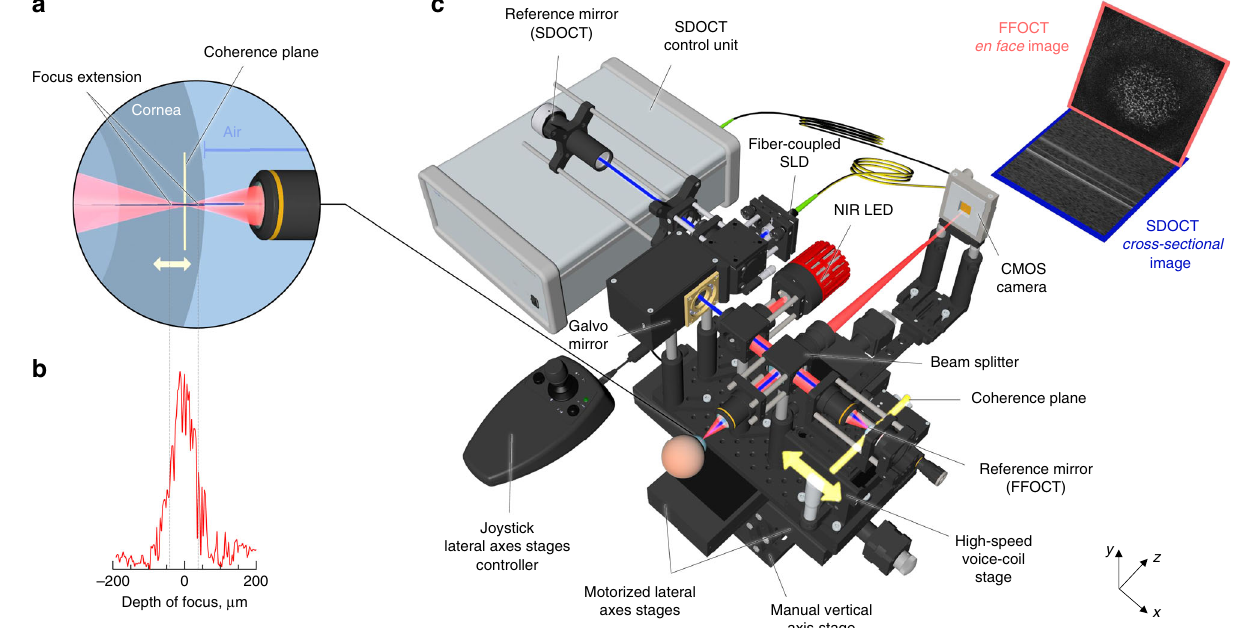
Fig. 1 Common-path FF/SD OCT with axial eye tracking and real-time defocus adjustment. a Side-view of the FFOCT sample arm with the cornea. Location of the focus changes with changing corneal position, due to refraction at the air-cornea boundary (Supplementary Movie 1). The location of the coherence plane (depicted in yellow), corresponding to the position of the FFOCT reference arm, also shifts, but in the opposite direction, leading to an optical mismatch between the two and loss of FFOCT signal. b Measured depth of focus. c The microscope consists of two interferometers: FFOCT, which acquires en face images using a 850 nm light-emitting diode illumination (depicted in red), and SDOCT, capturing cross-sectional images with a 930 nm superluminescent diode light (depicted in blue). SDOCT data is used to calculate the current corneal position and the optical mismatch correction required, which is fed into the fast voice coil stage in the FFOCT reference arm. The stage shifts rapidly to place the coherence plane within the changing position of the depth of focus. As a result, the FFOCT interferometer arms match, and en face images are acquired consistently and in real-time (Supplementary Movies 1, 2). All unlabeled scale bars are 400 µ m. The source data underlying the plot in b are provided as a Source Data fi